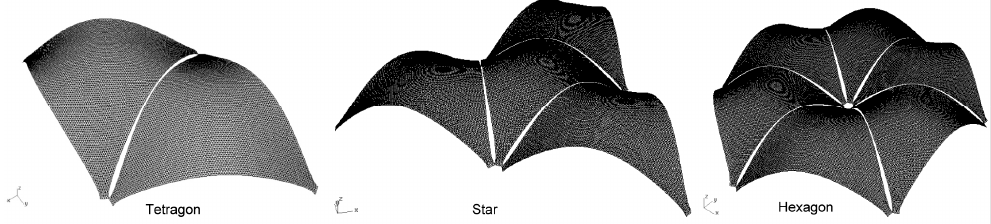
Figure 2. Combinations of the shell and three-dimensional meshes in the AutoCAD (Autodesk Inc.) environment.